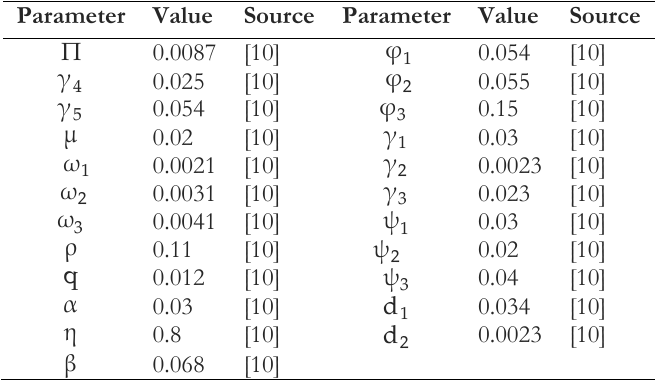
Table 1. Parameter values used in